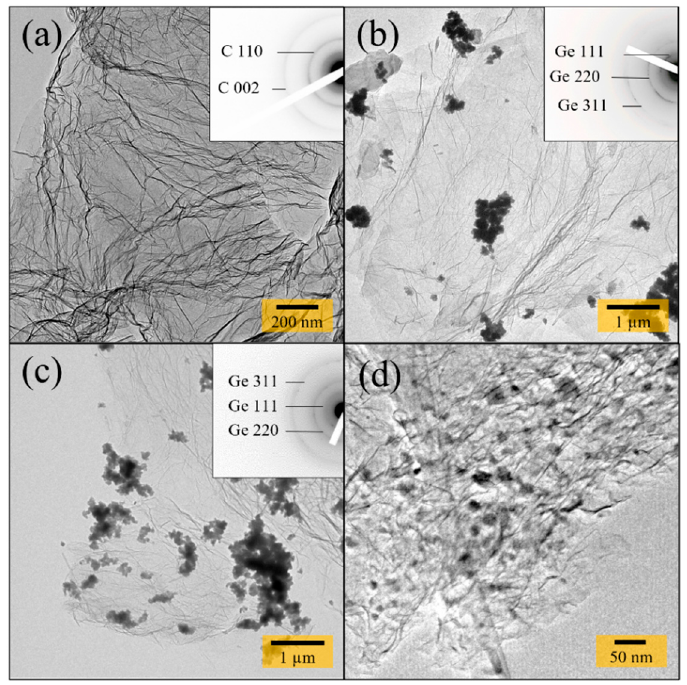
Figure 6. TEM images of as-prepared ( a ) NrGO, ( b ) 10Ge/NrGO, ( c ) 20Ge/NrGO products, and ( d ) high magnification TEM image of 20Ge/NrGO nanocomposite.